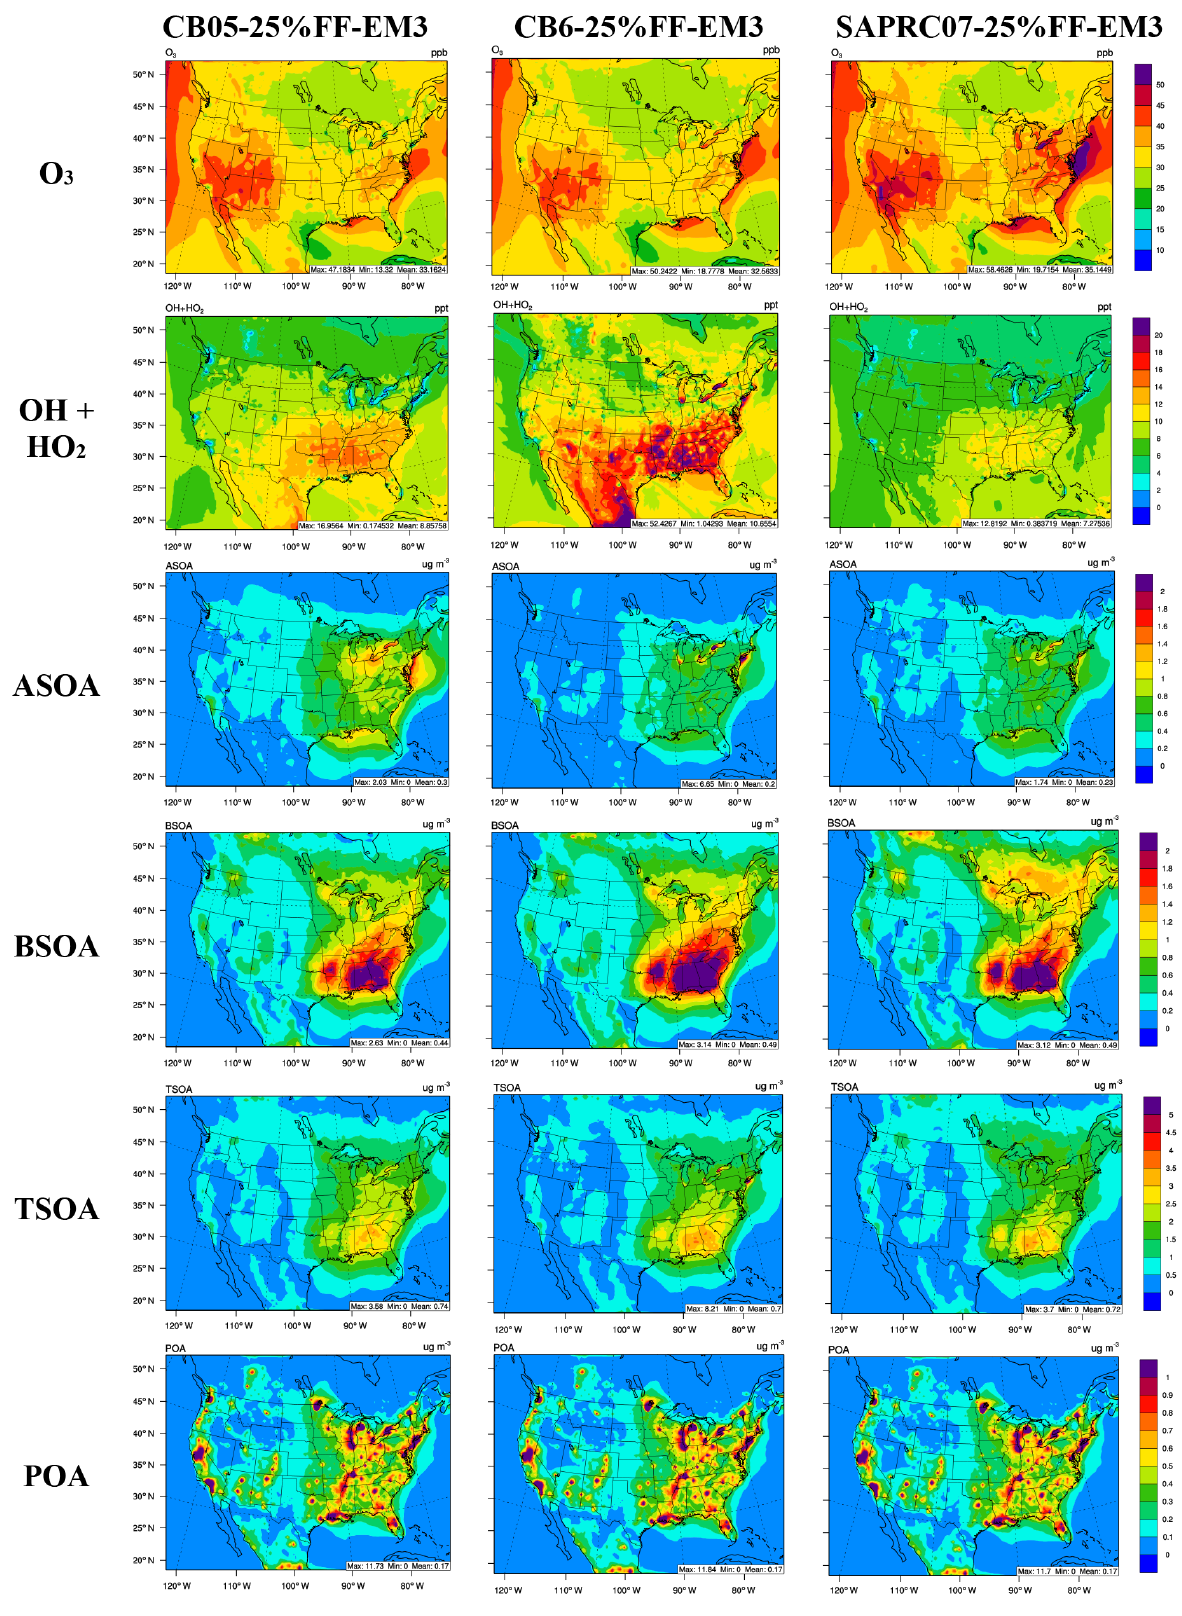
Figure 6. Spatial plots of several gas and aerosol species for the three cases with different gas-phase